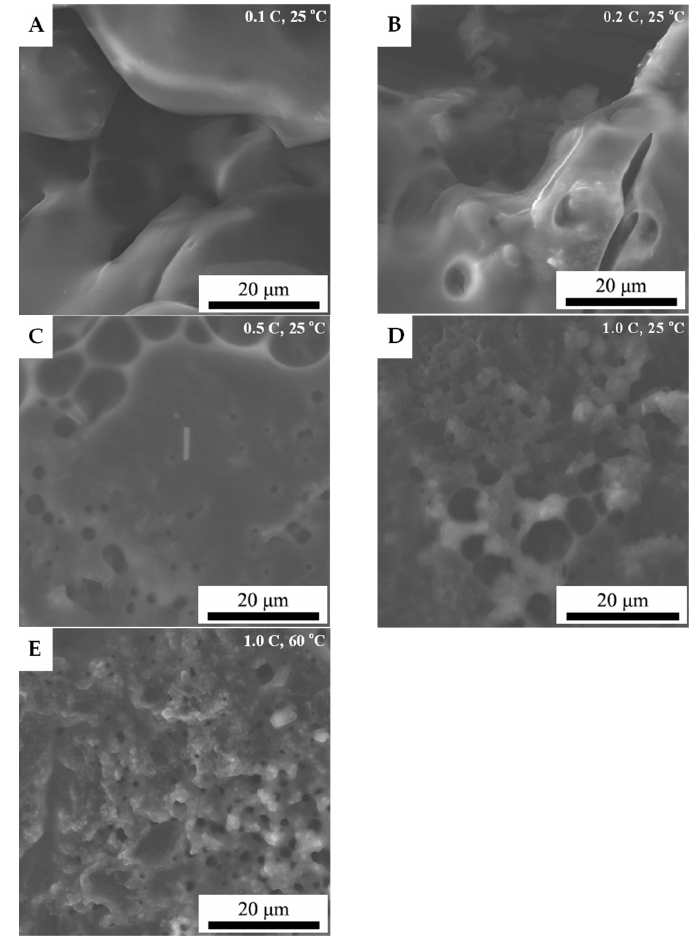
Figure 9. The SEM morphologies of the lithium anodes of [Li metal anode | TLPEC electrolyte | LiFePO 4 -based cathode] batteries after 100 charge–discharge cycles at various current densities and temperatures: ( A ) 0.1 C at 25 °C; ( B ) 0.2 C at 25 °C; ( C ) 0.5 C at 25 °C; ( D ) 1 C at 25 °C; and ( E ) 1 C at 60 °C.